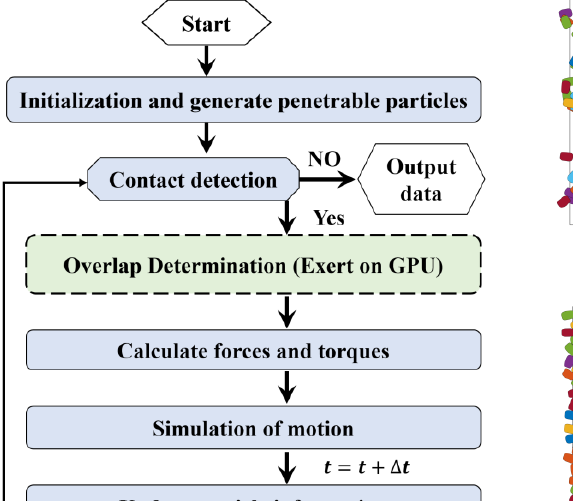
Figure 4. An example of dynamic packing super-ellipses (packing fraction of 80%, container = 100 × 100 , 𝐷 𝑒𝑞 = 5 , 𝑎 𝑏⁄ = 1.5 and 𝑚 = 1.5 ) and polygon (regular pentagon). ( a ) Flow chart for the packing process; ( b ) Initial state of packing, highly penetrable, particle number 𝑁 = 407 ; ( c ) Final state of packing, particle number 𝑁 = 451 and 450 (including periodic ones) for super-ellipse and regular pentagon, respectively.